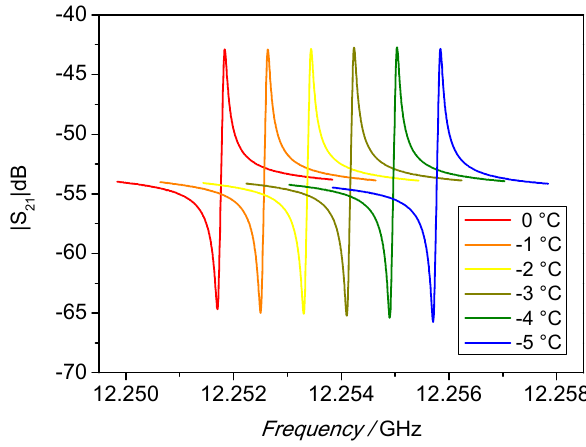
Figure 8. Change of the resonator spectrum with temperature.